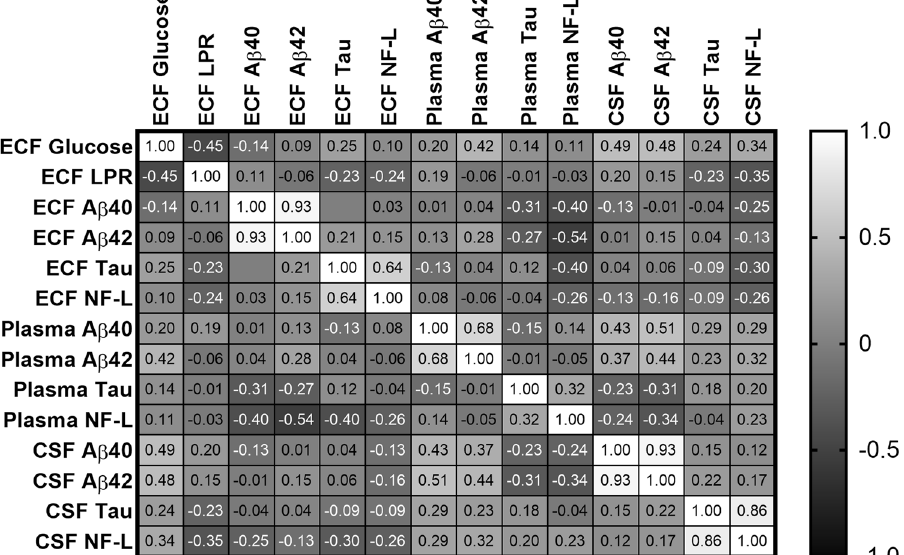
Figure 4. Correlations matrix between biomarkers in extracellular fluid (ECF), cerebrospinal fluid (CSF) and plasma. There was a strong correlation between levels of Aβ40 and Aβ -42 in ECF (ρ = 0.93, p < 0.05), plasma (ρ = 0.68, p < 0.05) and CSF (ρ = 0.93, p < 0.05), as for levels of tau and neurofilament light (NF-L) in ECF (ρ 0.64, p < 0.05) and CSF (ρ = 0.86, p < 0.05), whereas in plasma this correlation was moderate (ρ = 0.32, p < 0.05). ECF = extracellular fluid; LPR = lactate pyruvate ratio; Aβ = amyloid beta; NF-L = neurofilament light. Legend shows strong negative correlation in black and strong positive correlation in